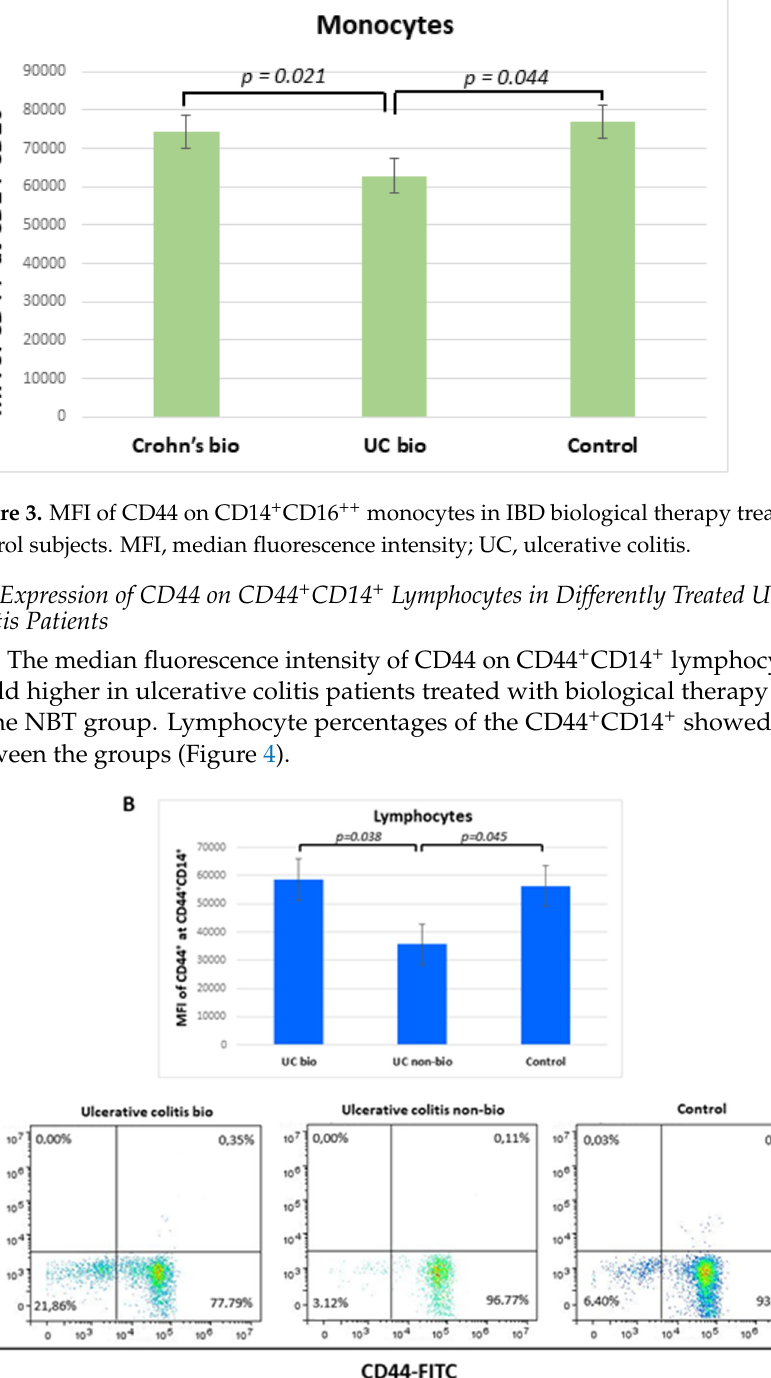
Figure 4. Percentage of CD44 + CD14 + lymphocytes ( A ) and their CD44 median fluorescence intensity ( B ) in ulcerative colitis patients. MFI, median fluorescence intensity . 3.8. Percentage of CD44 + Granulocytes in Crohn’s Disease Patients